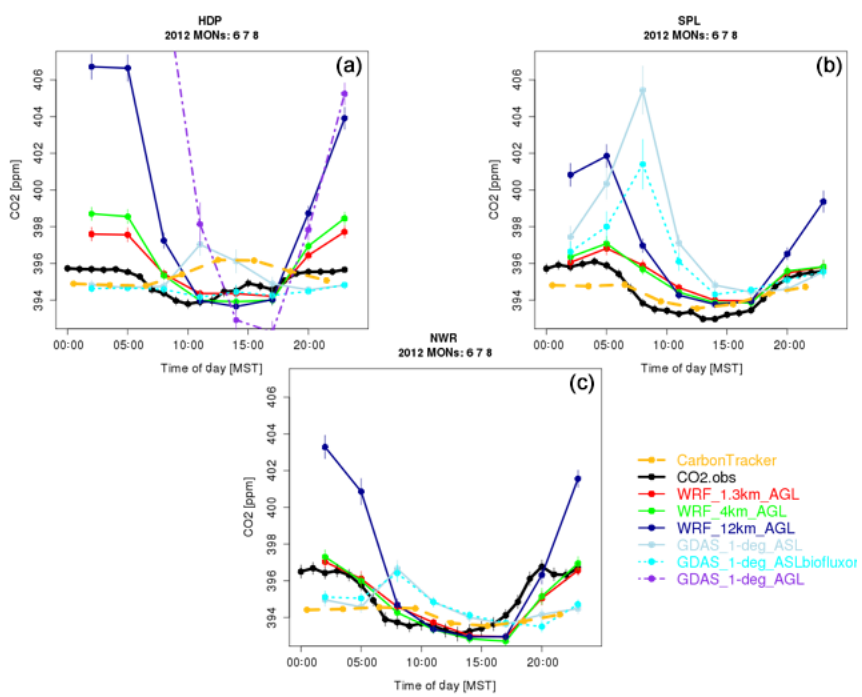
Figure 3. The average diurnal CO 2 pattern during June–August 2012 as observed at the three mountaintop sites in the RACCOON network: Hidden Peak (HDP), Storm Peak Laboratory (SPL), and Niwot Ridge (NWR). Compared against the observations are simulated diurnal CO 2 patterns from different models: CarbonTracker, STILT driven with WRF at different grid spacings, and STILT driven with GDAS. Multiple GDAS-driven STILT model configurations are shown, including runs without fixes to the biospheric fluxes (“biofluxorig”; see the Supplement) as well as releasing air parcels at the elevations of the sites above mean seal level (ASL) or, for HDP only, at the inlet height (Table 1) above the model’s ground level (AGL). All of the WRF-driven STILT runs place the release point of air parcels following the AGL configuration. Error bars denote standard errors of the diurnal